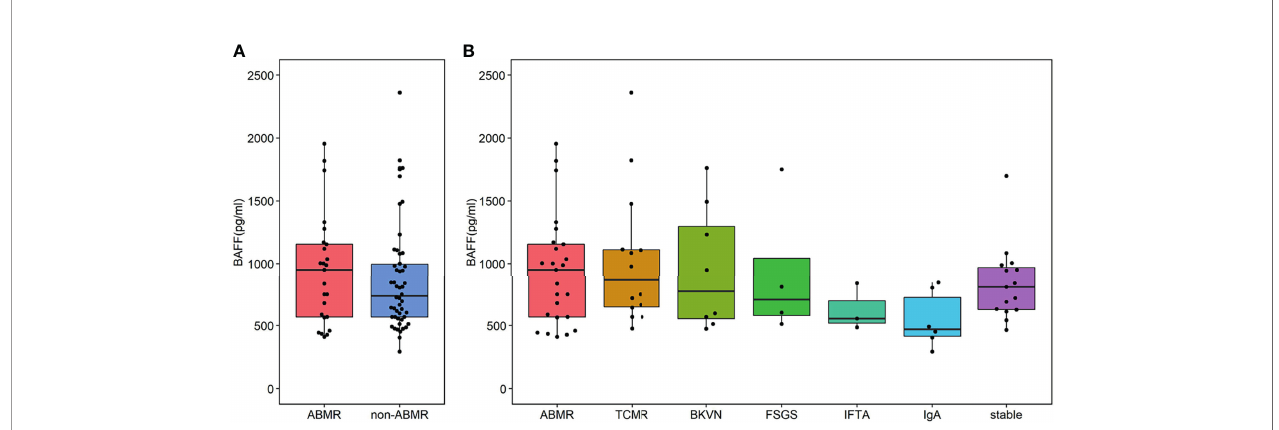
FIGURE 2 | Serum B cell-activating factor (BAFF) levels in kidney transplant recipients. (A) The BAFF levels of the antibody-mediated rejection (ABMR) group was comparable to that of the non-ABMR group [951.92 (566.09, 1,162.97) pg/ml vs. 734.77 (564.95, 1,020.04) pg/ml, P = 0.438]. The end points of the lower and upper line segments represent 5% and 95%, respectively. The lower and upper horizontal lines of the boxplot mean the fi rst and the third quartile, respectively, while the mid one represents the median. The solid points were outliers (<5th percentile or >95th percentile). (B) No signi fi cant difference was observed in these groups [951.92 (568.15, 1,155.23) pg/ml vs. 862.32 (647.15, 1112.30) pg/ml vs. 773.09 (554.98, 1,297.68) pg/ml vs. 705.58 (580.18, 1,044.08) pg/ml vs. 55.10 (519.96, 696.14) pg/ml vs. 470.95 (415.30, 723.17) pg/ml vs. 812.46 (633.45, 965.26) pg/ml, P = 0.168].